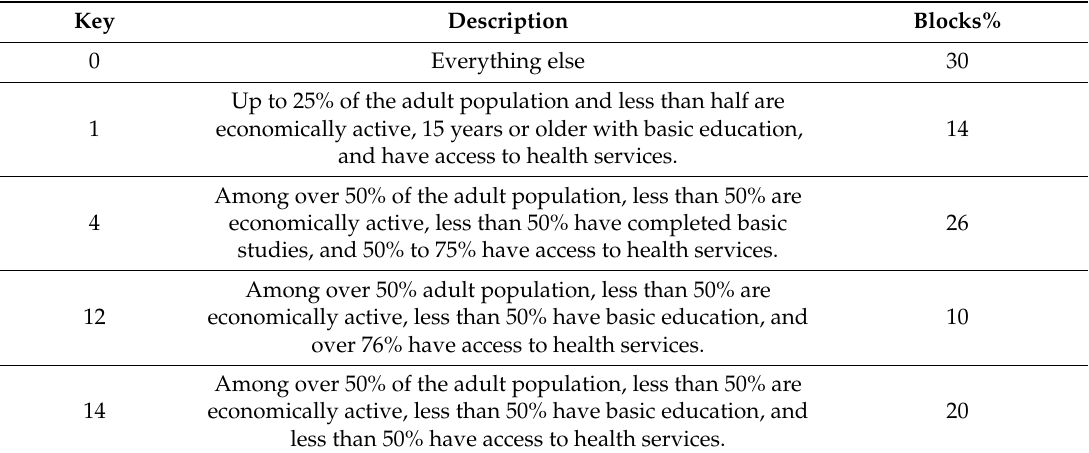
Table 3. Summary of determining the definitive blocks of the conglomerates.